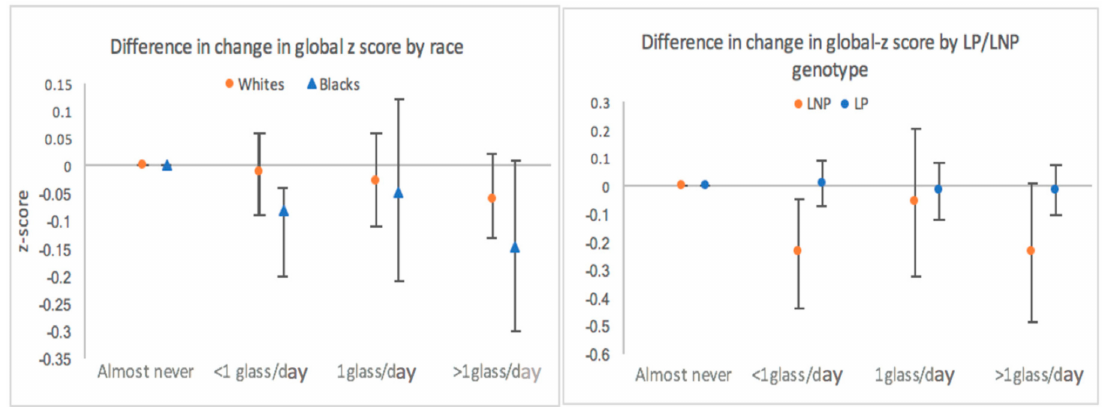
Figure 3. Estimated difference in the 20-year change in global z-score stratified by race and by LP/LNP genotype among Whites adjusted for age, gender, race-center, education level, APOE4, BMI, smoking, alcohol intake, diabetes, physical activity, total energy intake and diet quality. ARIC Study. Abbreviations: LNP, lactase non-persistence; LP, lactase persistence. “Almost never” used as